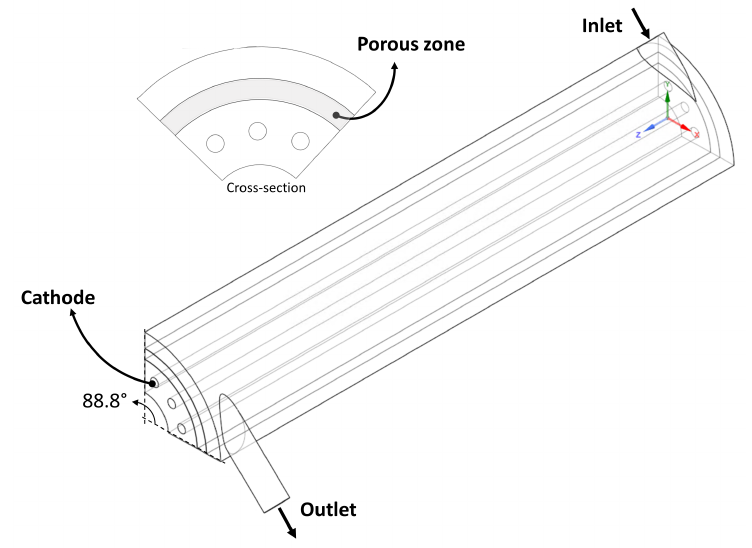
Figure 6. Computational domain used in PM modelling